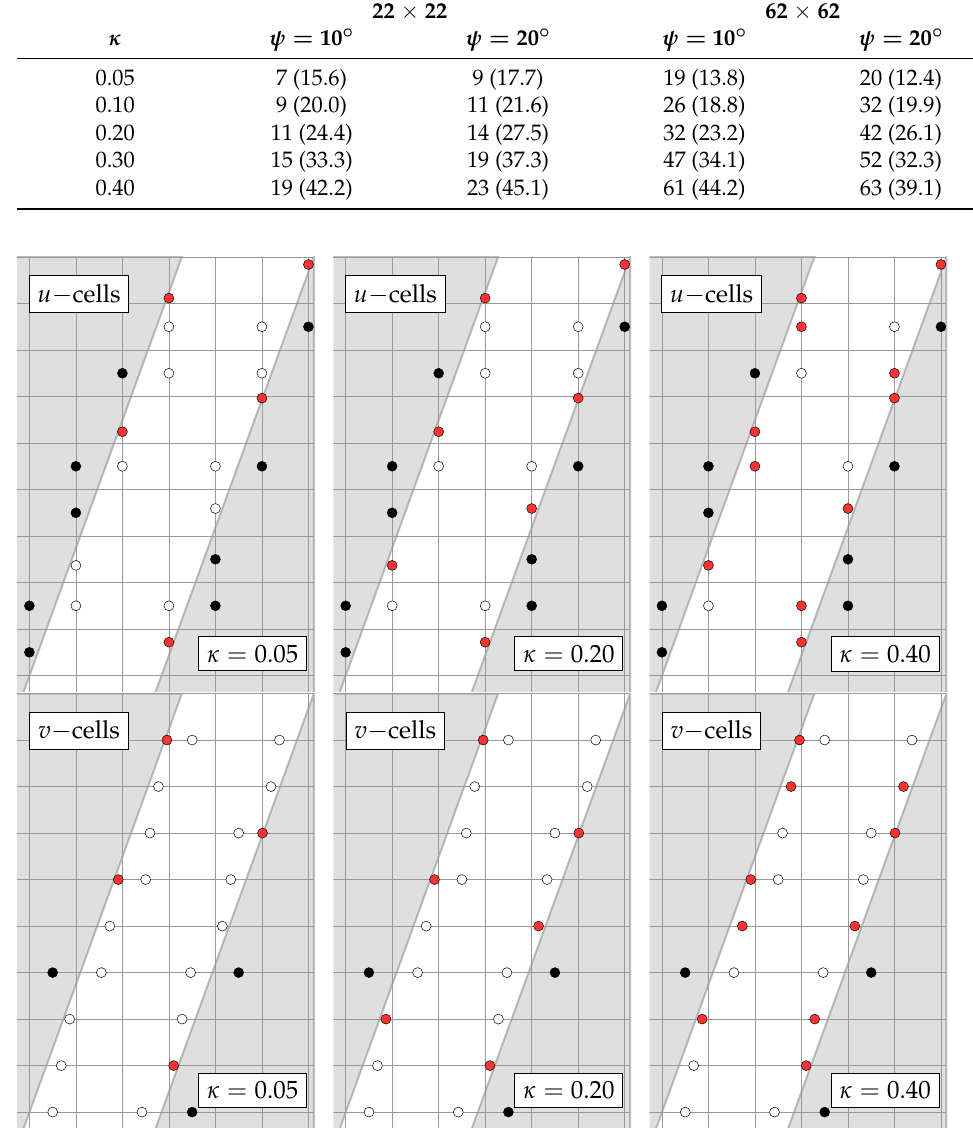
Figure 20. Fluid (white), solid (black) and slave (red) cells distribution around the immersed solids for the inclined channel flow case with the 22 × 22 grid and ψ =